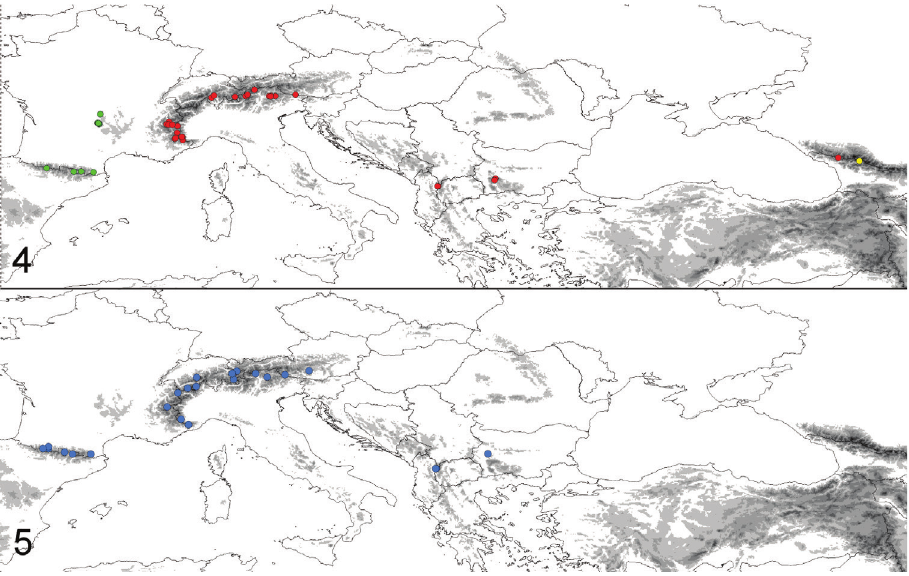
Figures 4–5. Distribution of investigated specimens of the Udea austriacalis species complex ( 4 ) and U. rhodo- dendronalis ( 5 ) in Europe 4 U. austriacalis (red), U. donzelalis (green), U. cretacea (yellow) 5 U. rhododendronalis (blue); altitudes ≥ 1,000 m are marked in increasingly darker grey shades every 500